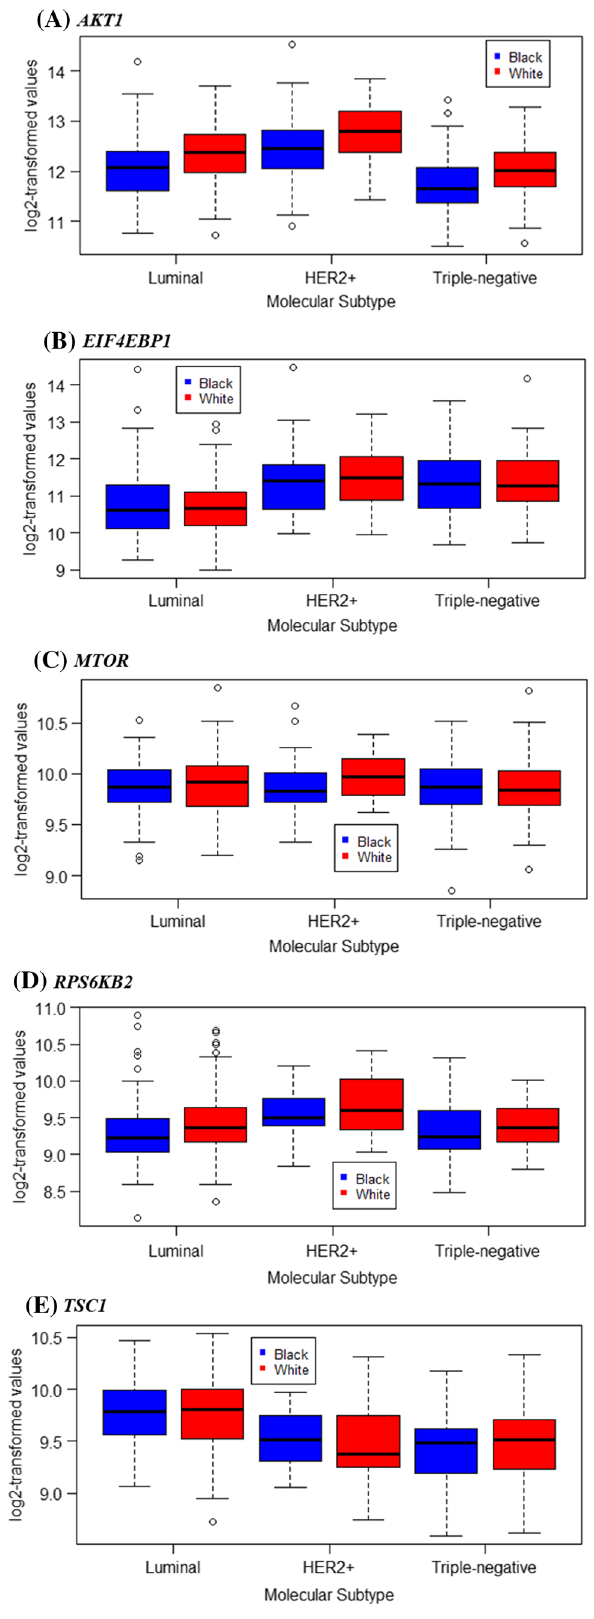
Fig. 2 mTOR gene expression levels among Black women vs. White women, stratified by molecular subtypes. A Lumi- nal, p-value = 0.0003; HER2+, p-value = 0.1696; Triple- negative, p-value = 0.0028, B Luminal, p-value = 0.8275; HER2+, p-value = 0.8599; Triple-negative, p-value = 0.9744, C Luminal, p-value = 0.7066; HER2+, p-value = 0.3314; Triple-negative, p-value = 0.8613, D